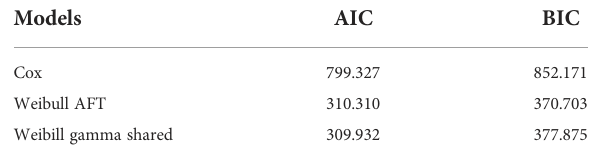
TABLE 8 Comparison of Cox PH, Weibull AFT, and Weibull gamma shared frailty model.